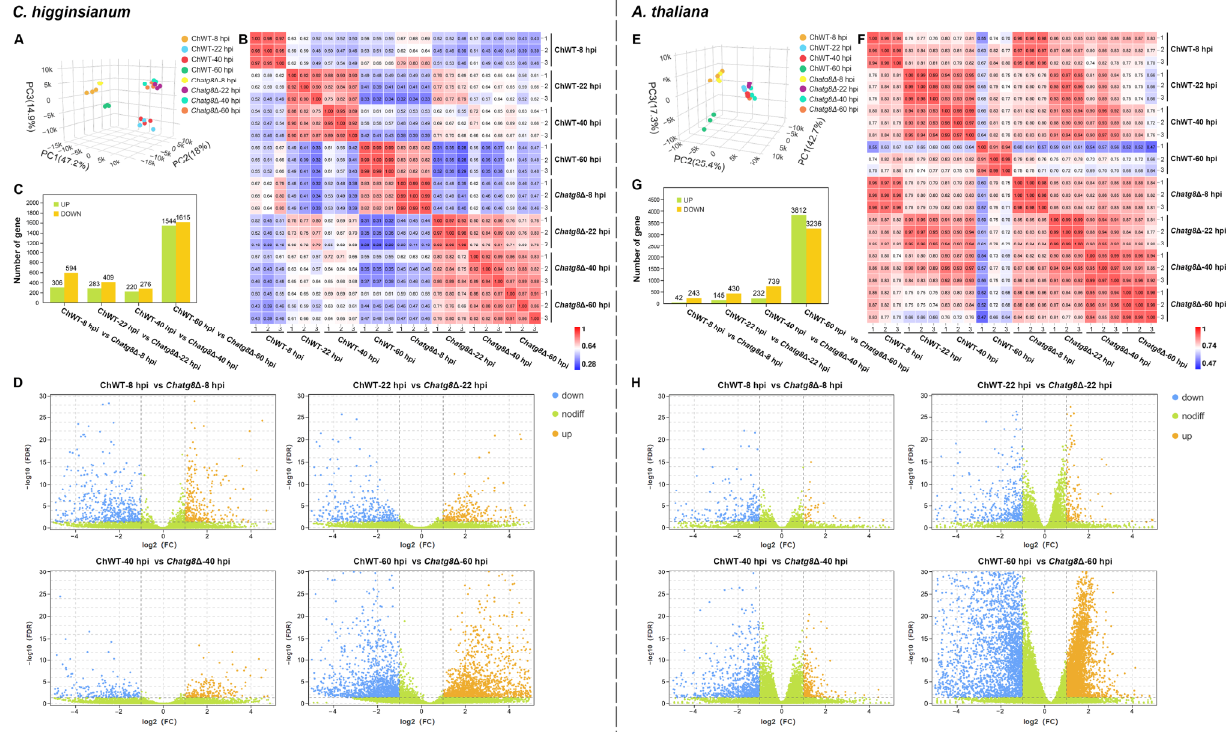
Figure 2. Overview of the transcriptome sequencing from C. higginsianum and A. thaliana at the four infection stages after inoculation with ChWT and Chatg8 Δ strains. ( A , E ) PCA analysis among the twenty-four samples from C. higginsianum and A. thaliana . ( B , F ) Pearson correlation between sample analysis from C. higginsianum and A. thaliana . ( C , G ) Number of up- and down-regulated genes in ChWT-8 hpi vs. Chatg8 Δ-8 hpi, ChWT-22 hpi vs. Chatg8 Δ-22 hpi, ChWT-40 hpi vs. Chatg8 Δ-40 hpi, and ChWT-60 hpi vs. Chatg8 Δ-60 hpi in C. higginsianum and A. thaliana . ( D , H ) Volcano plot of DEGs in the four comparison groups in C. higginsianum and A. thaliana . The horizontal axes are log2 (Fold Change) and the vertical axes are −log10 (FDR). The two vertical dashed lines are the threshold for 2-fold differences, and the horizontal dashed lines are FDR value 0.05 thresholds. An orange dot indicates an upregulated gene, a blue dot indicates a downregulated gene, and a green dot represents a gene with a non-significant difference in expression.